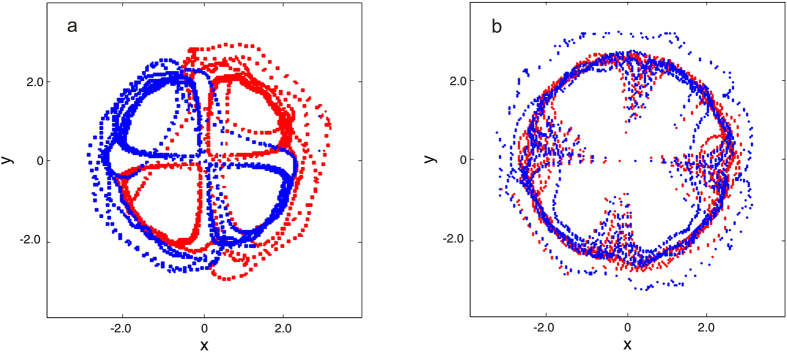
Dynamics of quadrupoles in the systems with quantum fluctuations.The blue and red dots show the trajectories of vortices with charge s = 1 and s = −1, respectively. (a) The trajectories of the vortices initially seeded at (±4.75, ±2.5) in the condensate. The total evolution time is 125t0. The chaotic motion of vortices starts from about 86t0. (b)The trajectories of the vortices initially seeded at (±4.75, ±4.0) in the condensate. The total evolution time is 167t0. The chaotic motion of vortices starts from about 128t0.